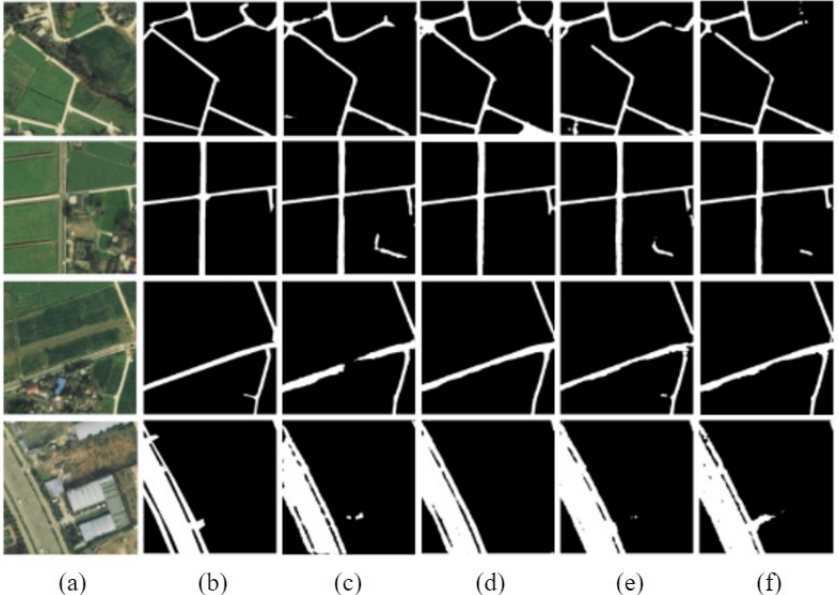
Figure 14. Comparison results of simple scene experiment. ( a ) Input image; ( b ) label image ( c ) D-